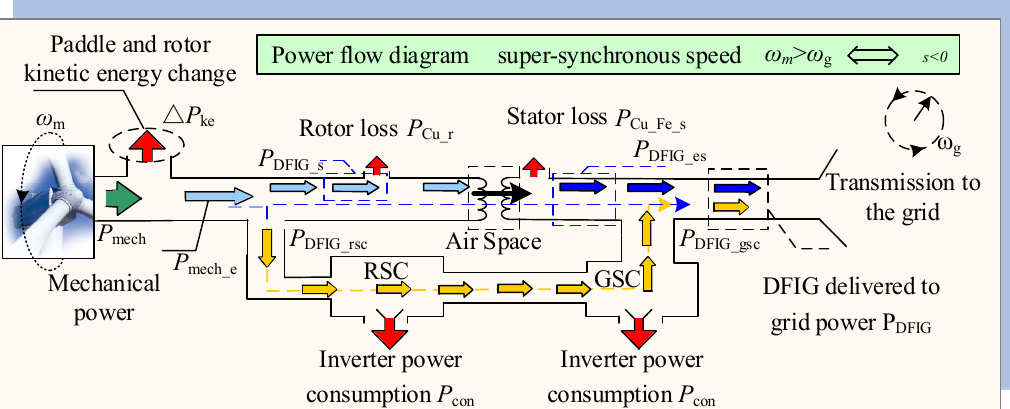
Figure 3. The power flow relation of the DFIG with an over-synchronous operation.